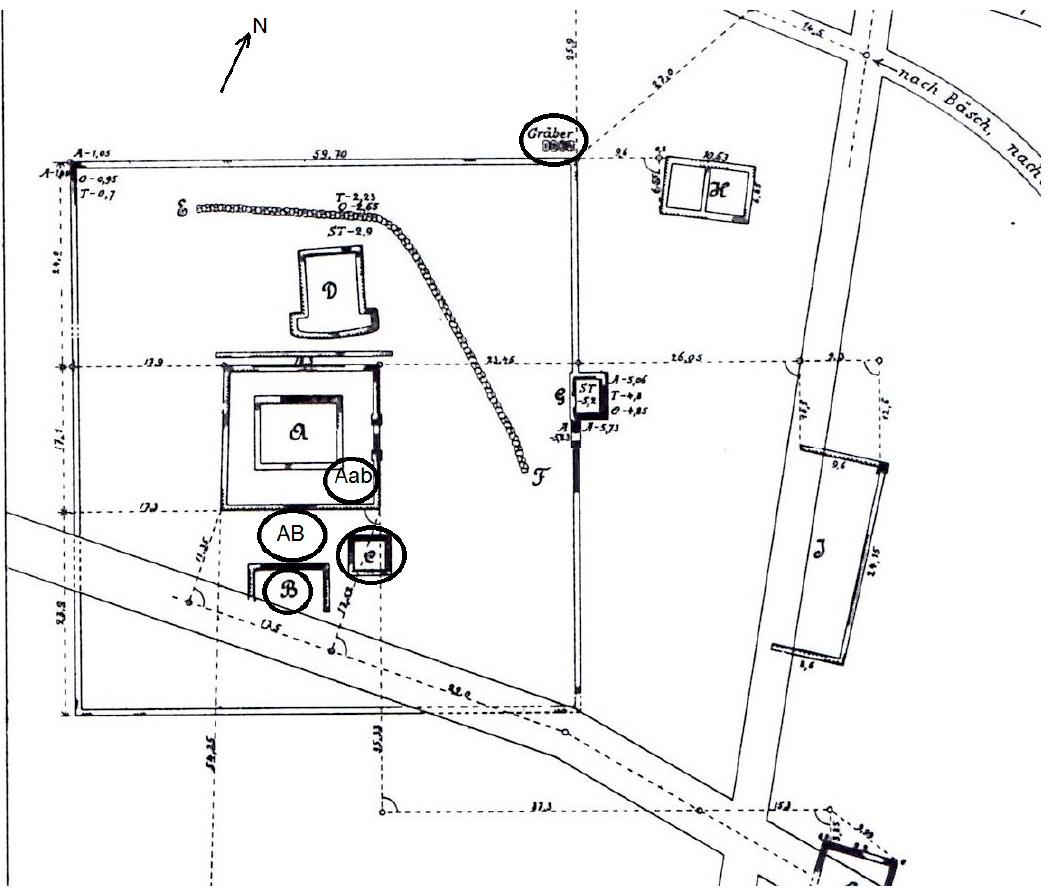
Figure 1. Details of the excavation map of Dhronecken, by Hettner (1901, p. XXII, 3a). Highlights and finding place indicators added by the author.